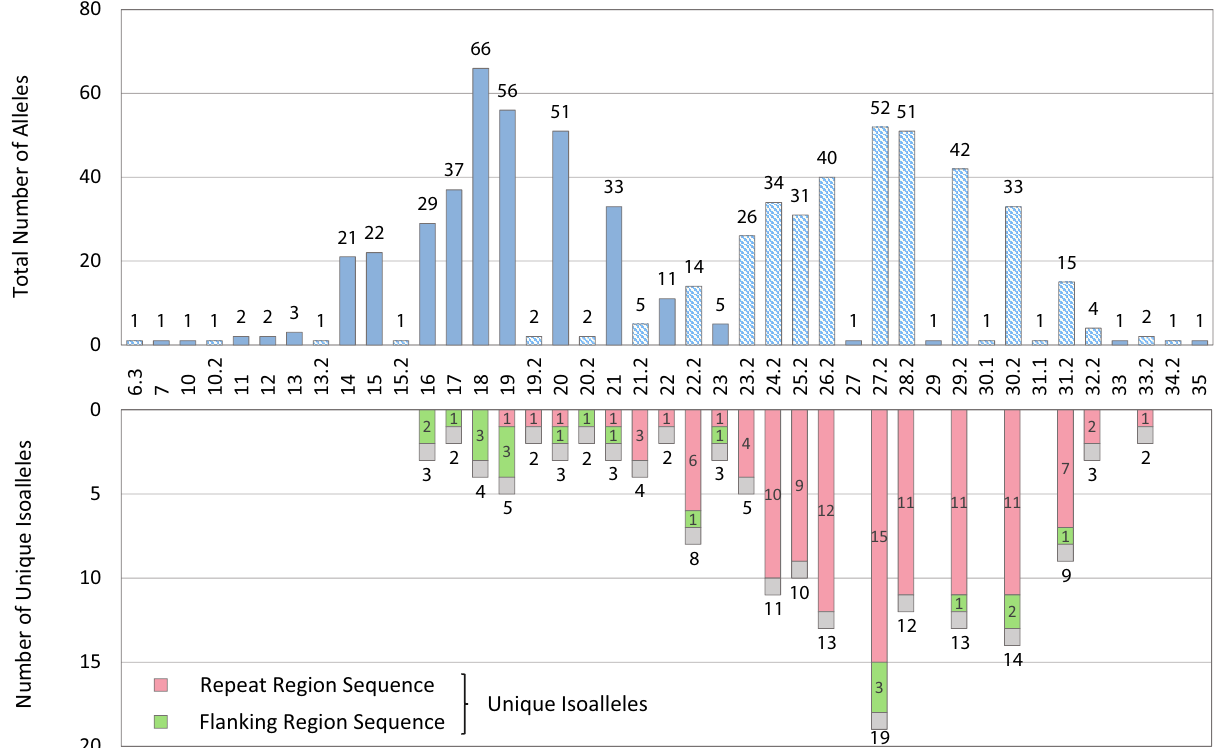
Figure 2. Allele distribution of SE33. The upper graph displays the total numbers of alleles by length. Microvariant alleles are indicated by hatched lines. The lower graph represents the number of isoalleles by variations in repeat and flanking